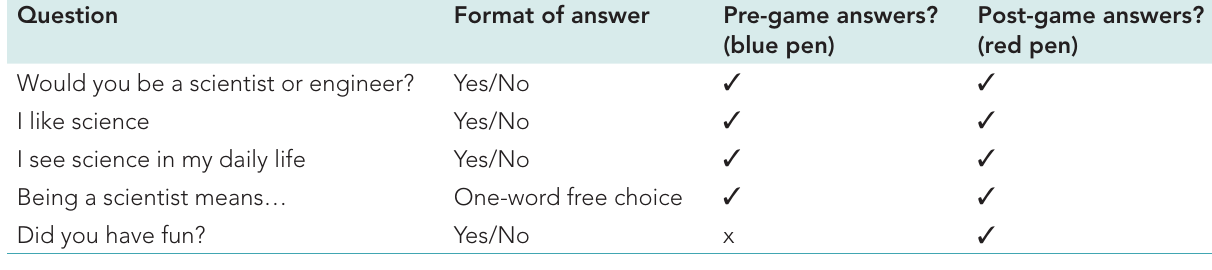
Table 1. List and format of questions answered before and after playing Diamond: The Game in the pilot sessions (Source: Authors,